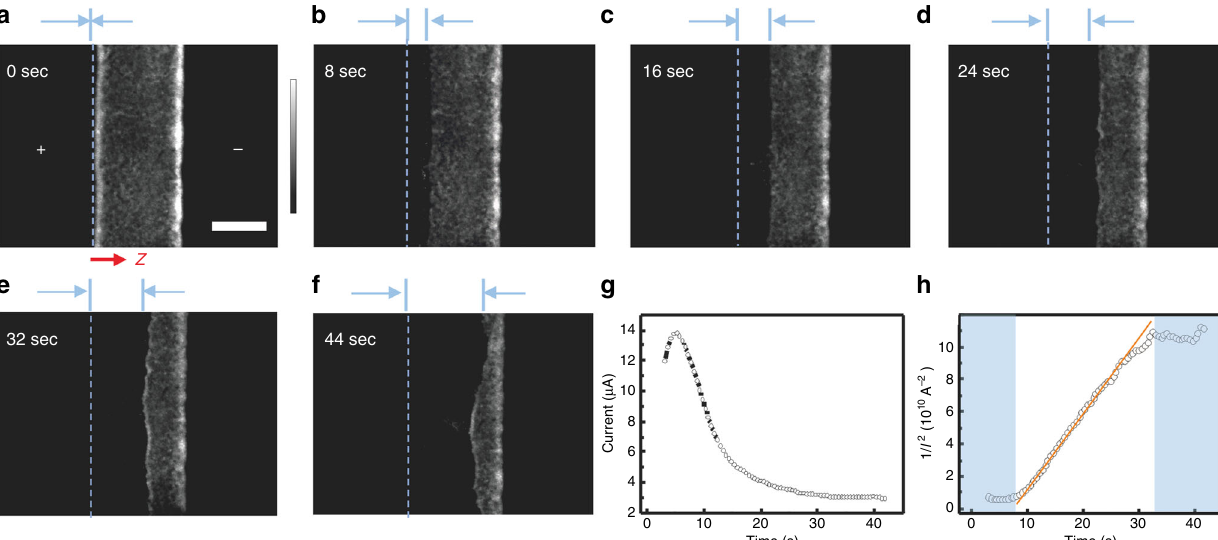
Fig. 1 Observation of a dark advancing front in a light-soaked perovskite. a – f Time-dependent PL images of a perovskite fi lm CH 3 NH 3 PbI 3 – x Cl x under an external electric fi eld (~2 × 10 4 V m – 1 ). The “ + ” and ‘–‘ signs indicate the polarity of the electrodes. The excitation intensity is ~35 mW cm – 1 with a wavelength of 440 nm, and the exposure time per image is 200 ms. The channel length is ~150 µ m. z(t) represents the PL quenched areas. The time- dependent z(t) is displayed in Supplementary Figure 1. The scale bar represents 100 μ m. The color bar is a gray value with arbitrary units, indicating the PL intensity. g , h Electrical current I and 1/ I 2 , respectively, monitored as a function of time during the measurement of experiment